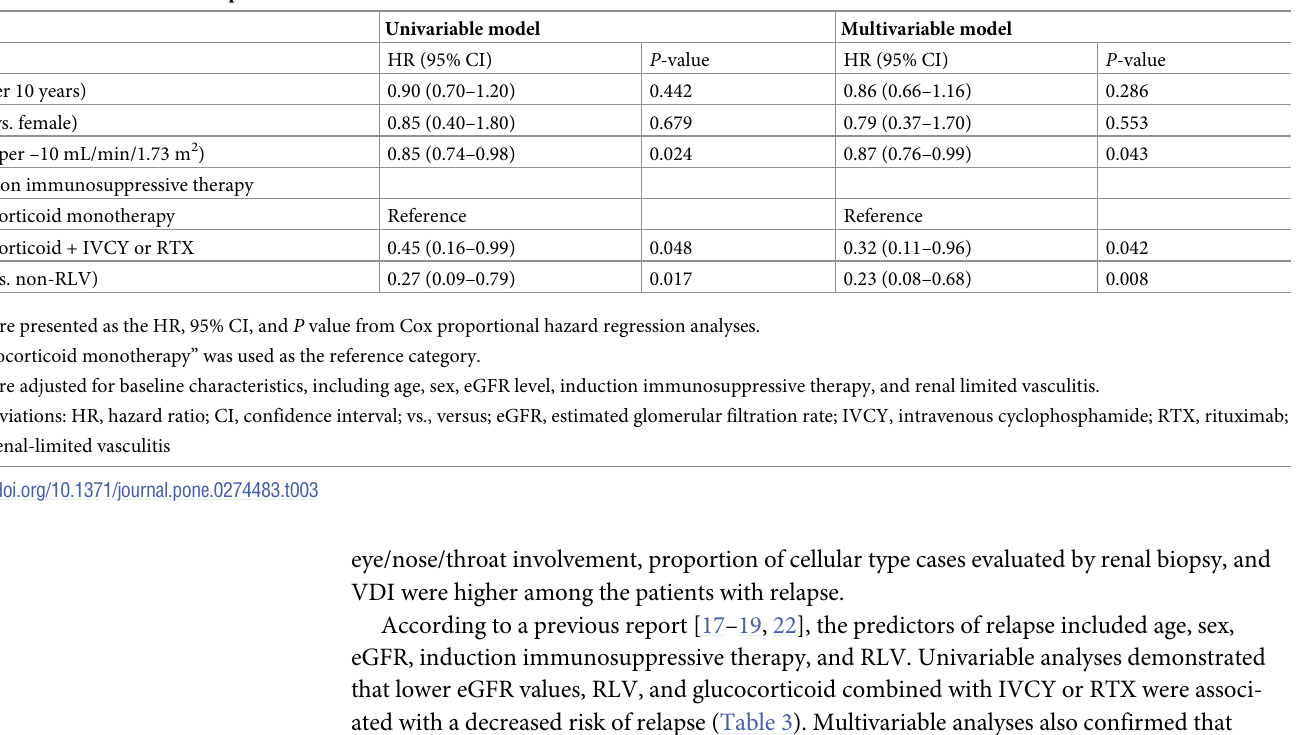
Table 3. Predictors of the first